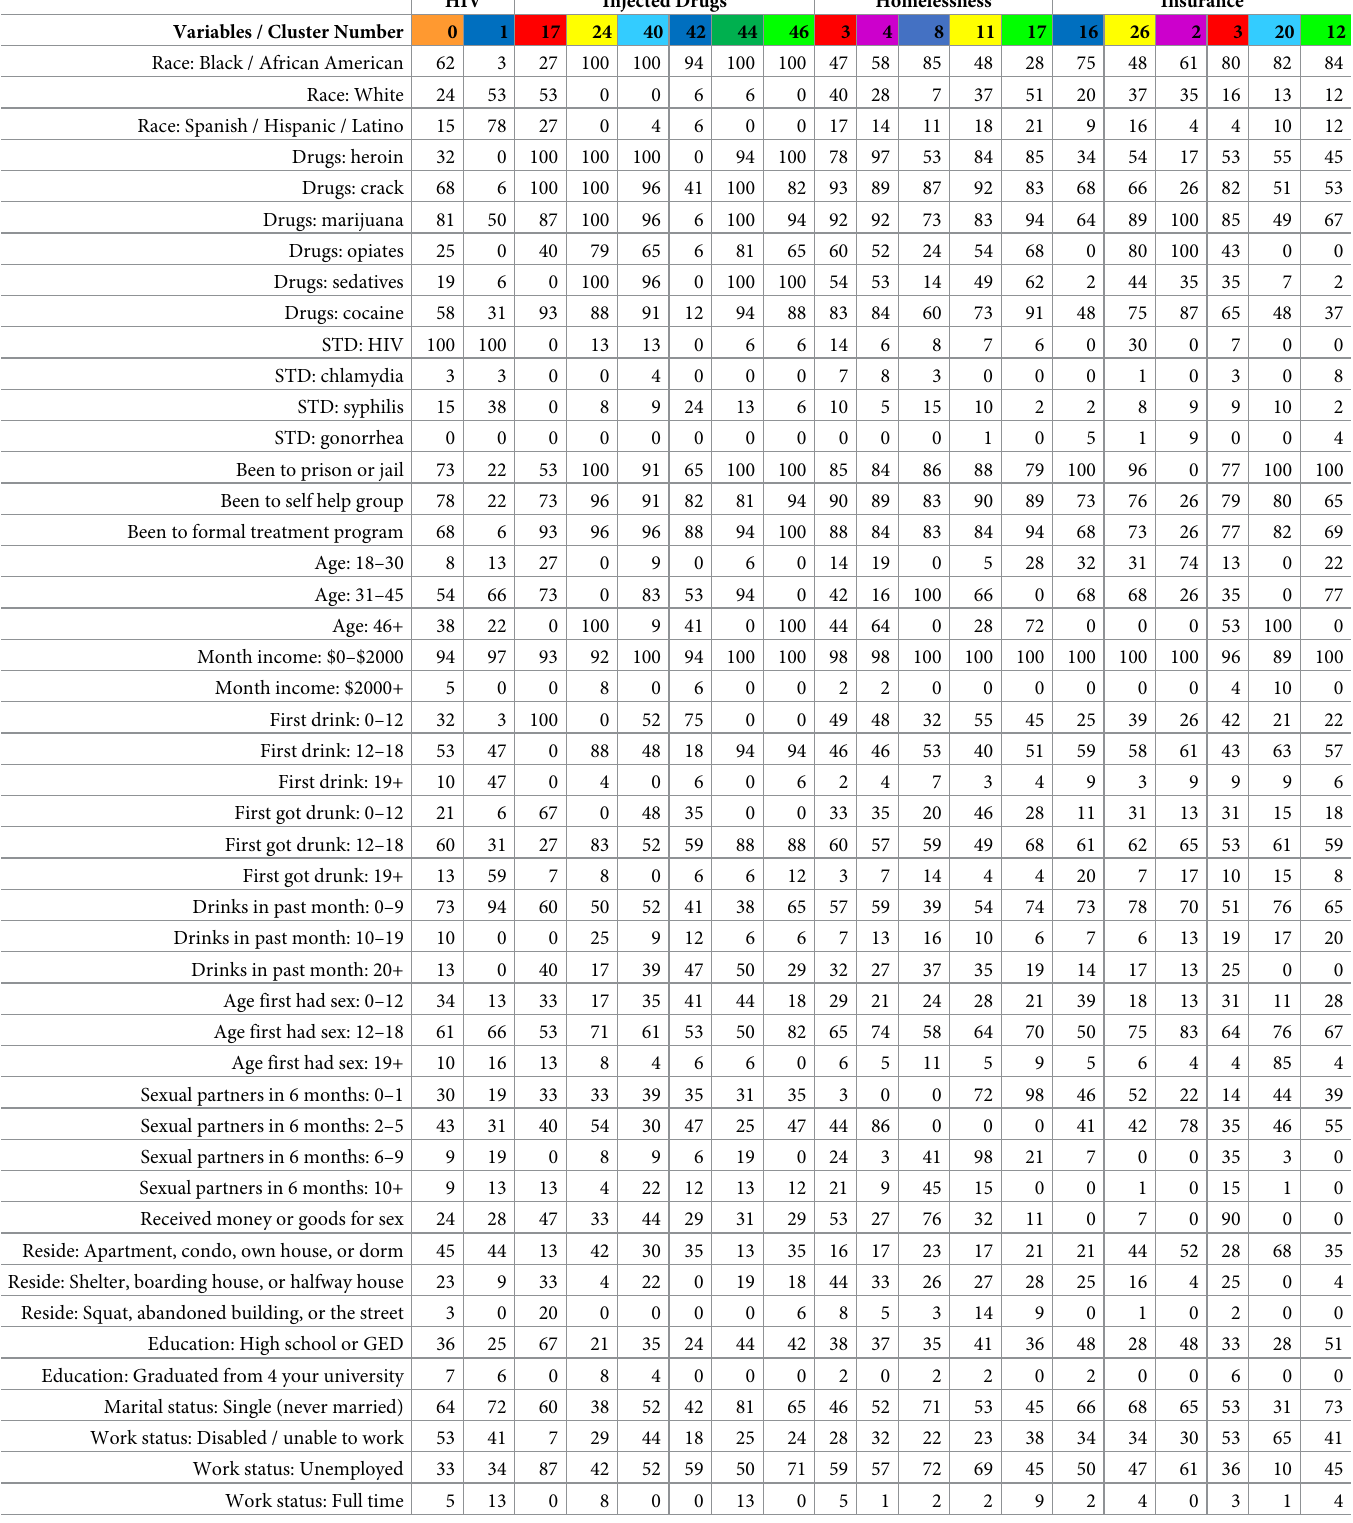
Table 3. Percentage of each cluster with a positive response for the listed variable. Clusters are coded by their colors on the corresponding figures. HIV Injected Drugs Homelessness